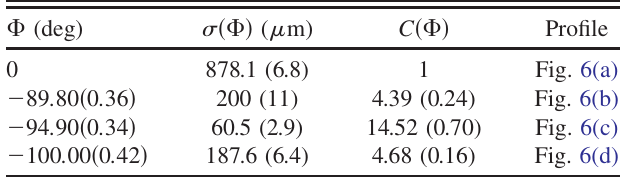
TABLE I. Measured values for rms bunch length (cid:1) ð (cid:1) Þ , com- pression factor C ð (cid:1) Þ as a function of the phase delay (cid:1) from the on-crest